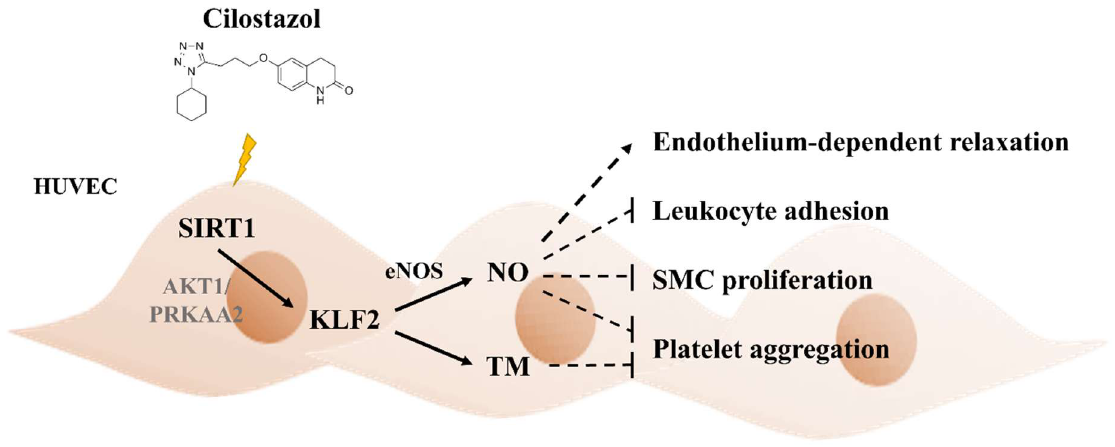
Figure 8. Illustration of the proposed molecular mechanism by cilostazol-treated HUVECs. The suggested working model for the cilostazol induction of KLF2. As delineated, cilostazol activates KLF2 through SIRT1 induction via AKT1 or PRKAA2 pathways, followed by stimulating eNOS and TM expression in HUVECs. Lines with arrowheads indicate activation. SMC, smooth muscle cells.